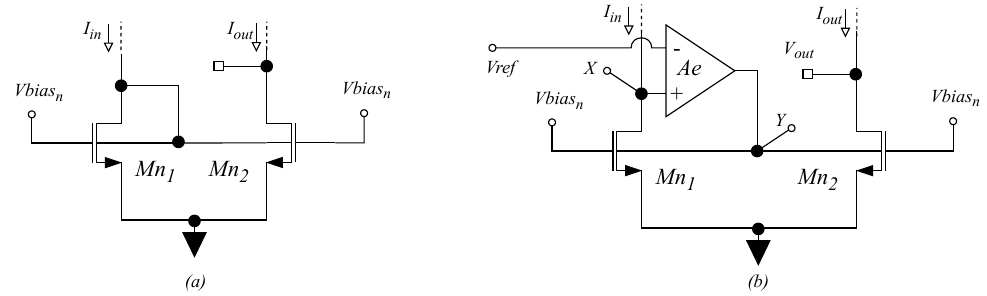
Figure 1. Conventional body-driven current mirror ( a ) and enhanced body-driven current mirror ( b